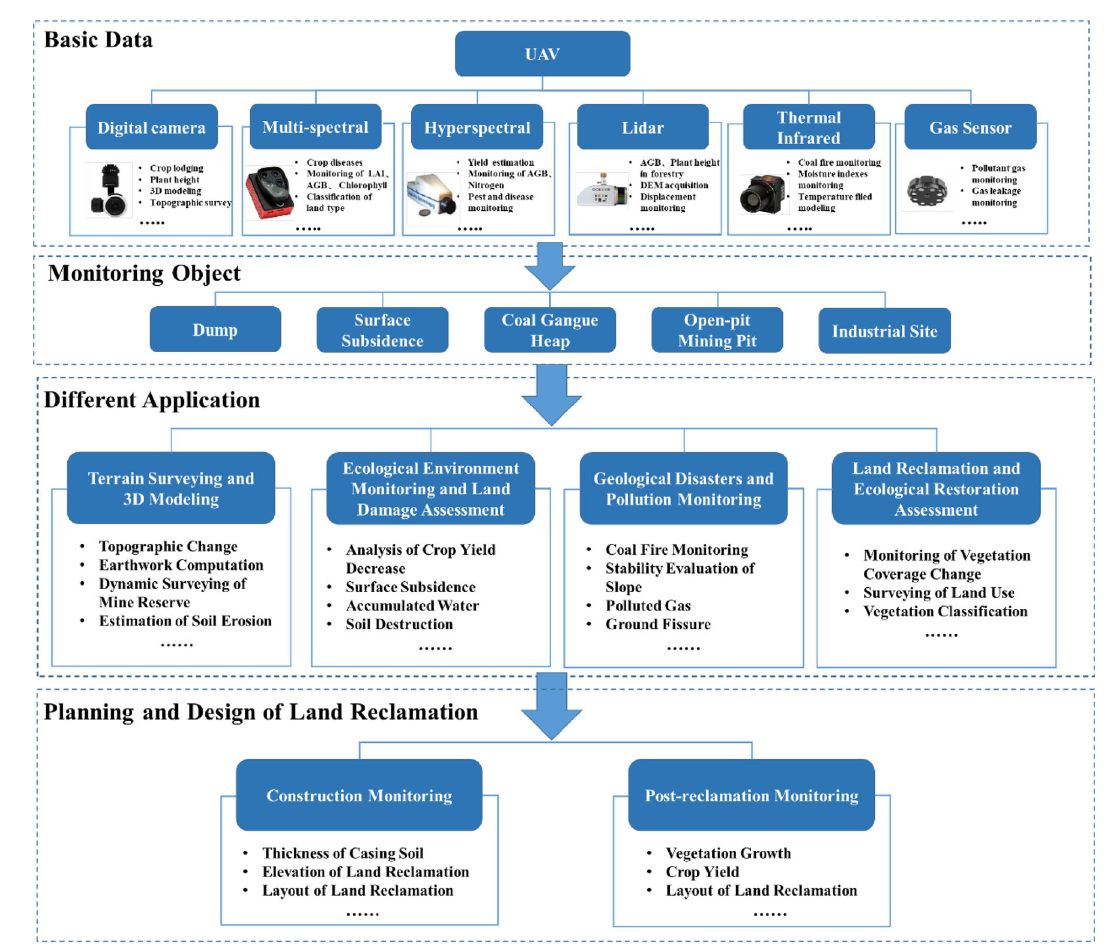
Fig. 5 The framework of UAV applications in